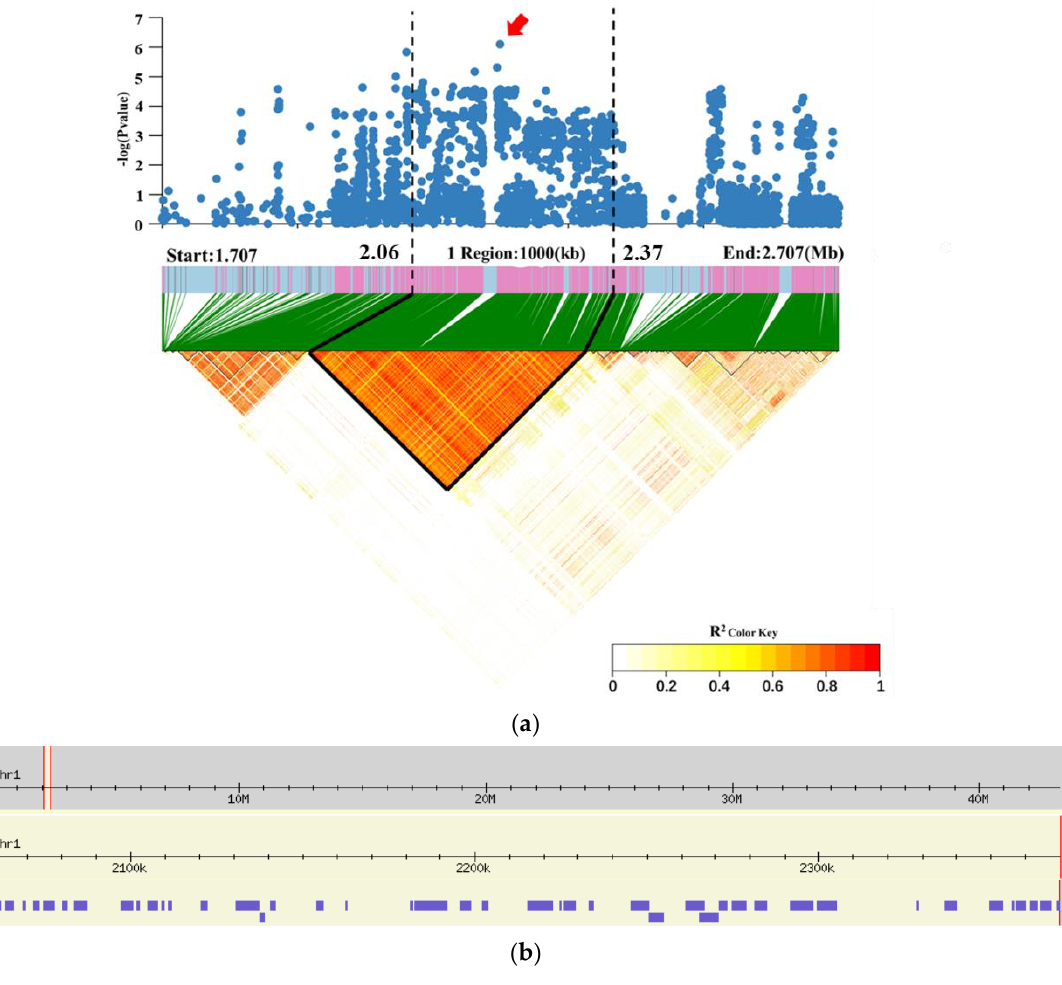
Figure 4. Candidate gene of qRG1.2 on chromosome 1. ( a ) Local Manhattan plot ( top ) and LD heatmap ( bottom ) surrounding the lead SNP. ( b ) Based on the Rice Annotation Project (RAP) [40], the 310 kb region contained 43 genes.